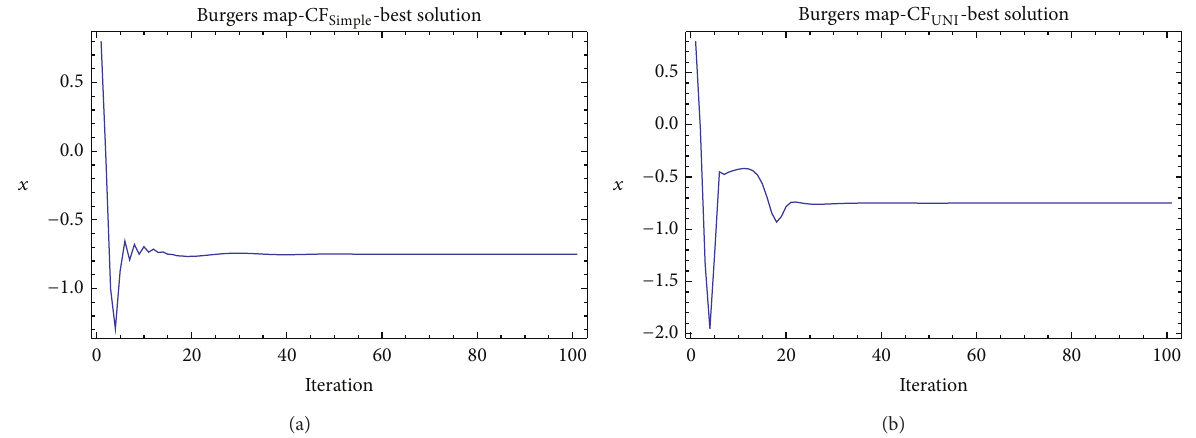
Figure 11: Simulation of the best individual solution, ChaosDE and Burgers map: case study 1,CF Simple (a); case study 2, CF